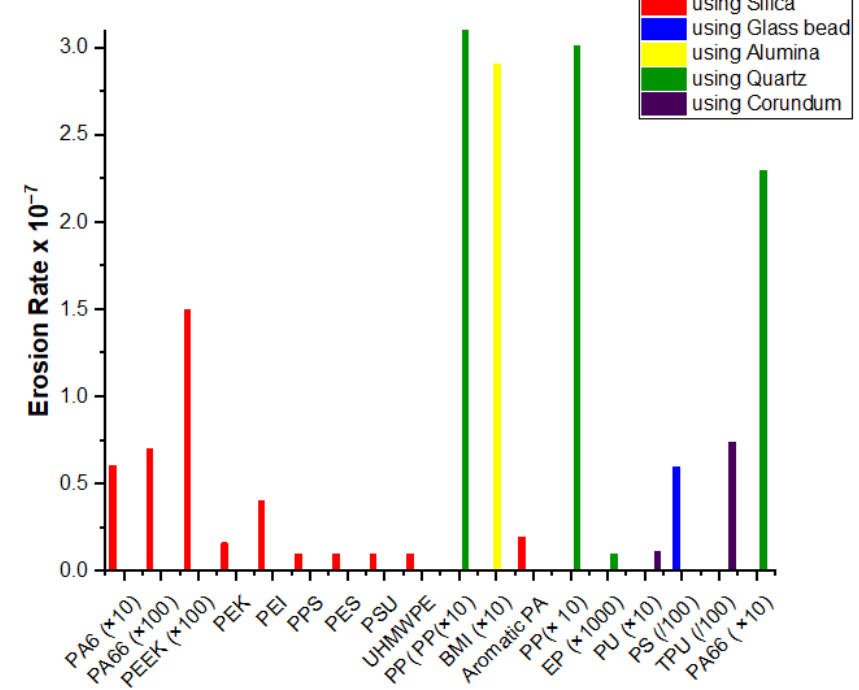
Figure 5. Minimum reported erosion rate ( × 10 − 7 ) of neat polymers at optimized impact velocity using different erodents [92].